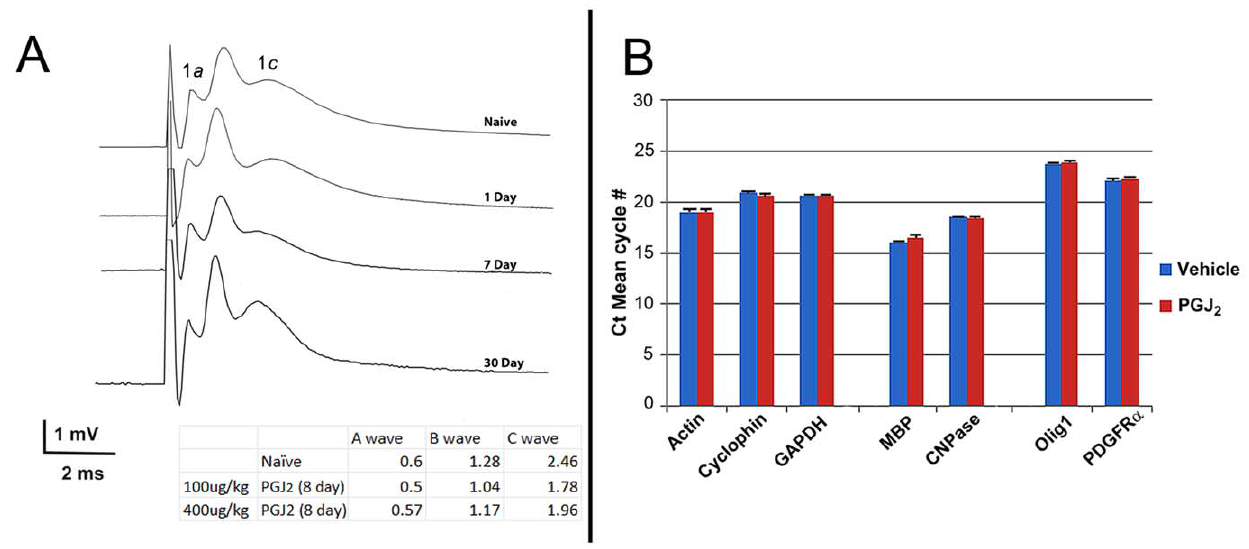
Figure 8. Analysis of PGJ 2 -related oligodendrocyte toxicity. A. Compound action potentials (CAPs) from naı¨ve ON and ON 1, 7, and 30 days after a single treatment of PGJ 2 (100 m g/kg).No significant changes from naı¨ve ONs were seen. Inset: Wave amplitude maxima of individual axon components, from the ONs of animals given either 100 ug- or 400 ug/kg PGJ 2 prior to testing TEM analysis of naı¨ve and 30 days post 400 m g/kg PGJ 2 . No differences are detectable in axonal appearance, myelination, or overall structure. Low power bar=500 nm High power bar=100 nm. C. Evaluation of oligodendrocyte (NG2( + )) precursors 30 days post-PGJ 2 administration (100 m g/kg). No differences in NG2( + ) cells were seen in the ON.